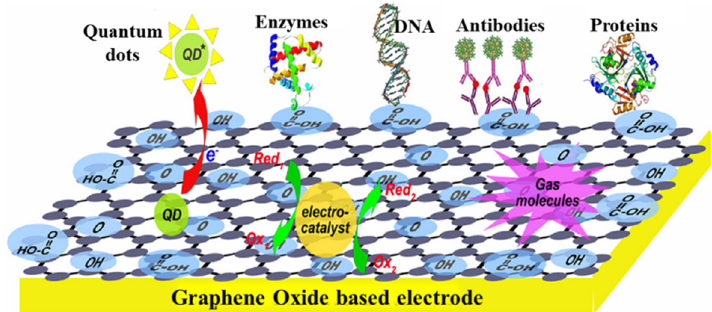
Figure 9. The scheme shows GO-based electrodes for electrochemical applications. Redrawn from [95]. © ACS Publishing.